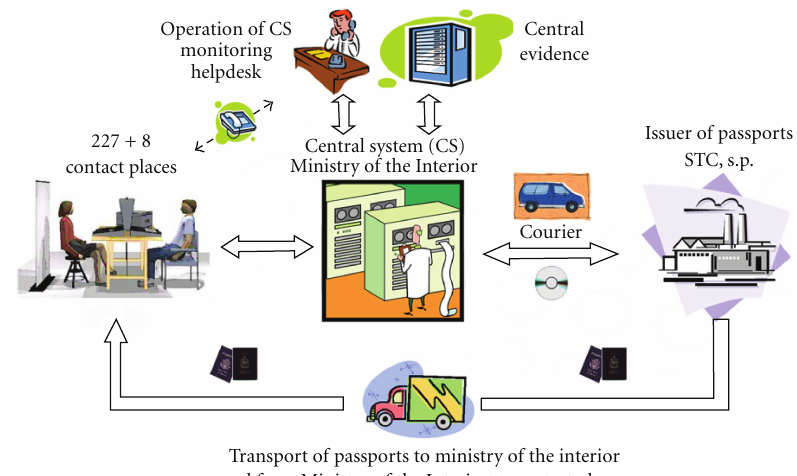
Figure 8: The Czech passport system architecture (source: Ministry of the Interior of the Czech